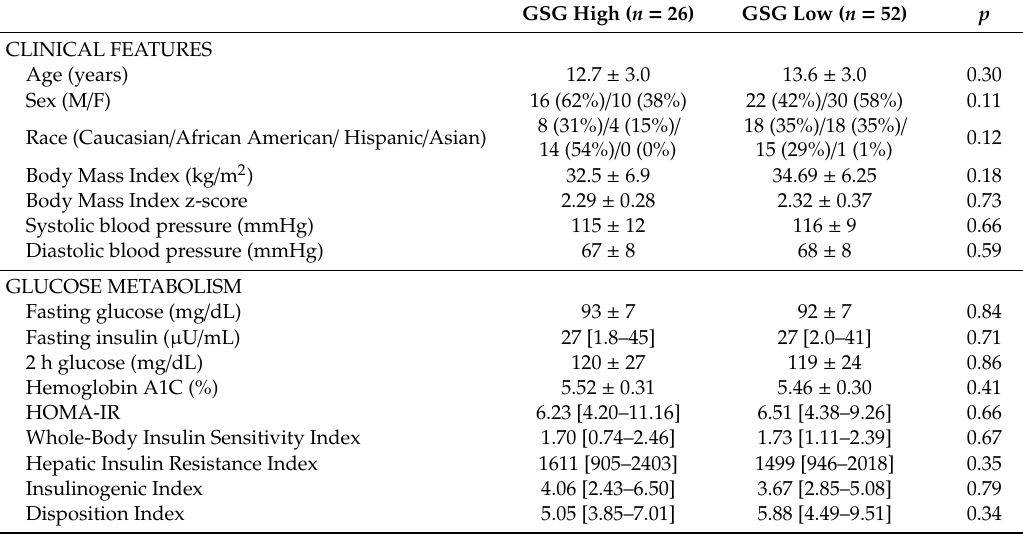
Table 1. Characteristics of participants stratified by glutamate–serine–glycine (GSG) index—high and